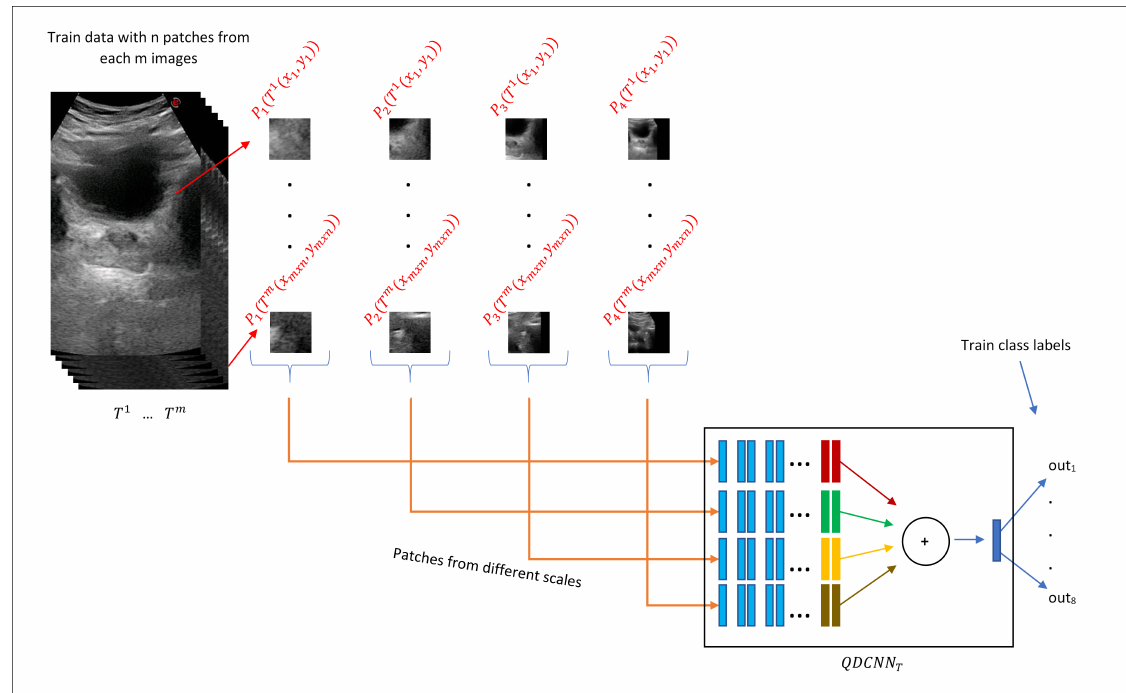
Figure 7. The training process on m transverse images T 1 , . . . , T m . Around the diameter endpoints of each m training image, n quadruplet patches ( PQ ( T 1 ( x 1 , y 1 ))) , . . . , ( PQ ( T m ( x mxn , y mxn ))) were extracted randomly. The transverse model QDCNN T was trained to predict eight classes where eight is the number _ of _ tasks × number _ of _ diameter _ end _ points